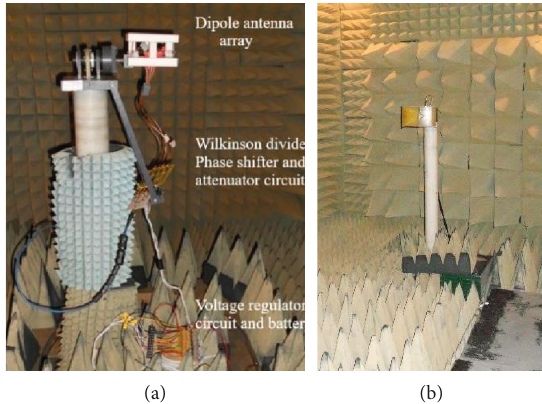
Figure 16: (a) Measurement setup of the dipole array and the RF beamformer circuit (transmitter) and (b) the horn antenna (receiver).